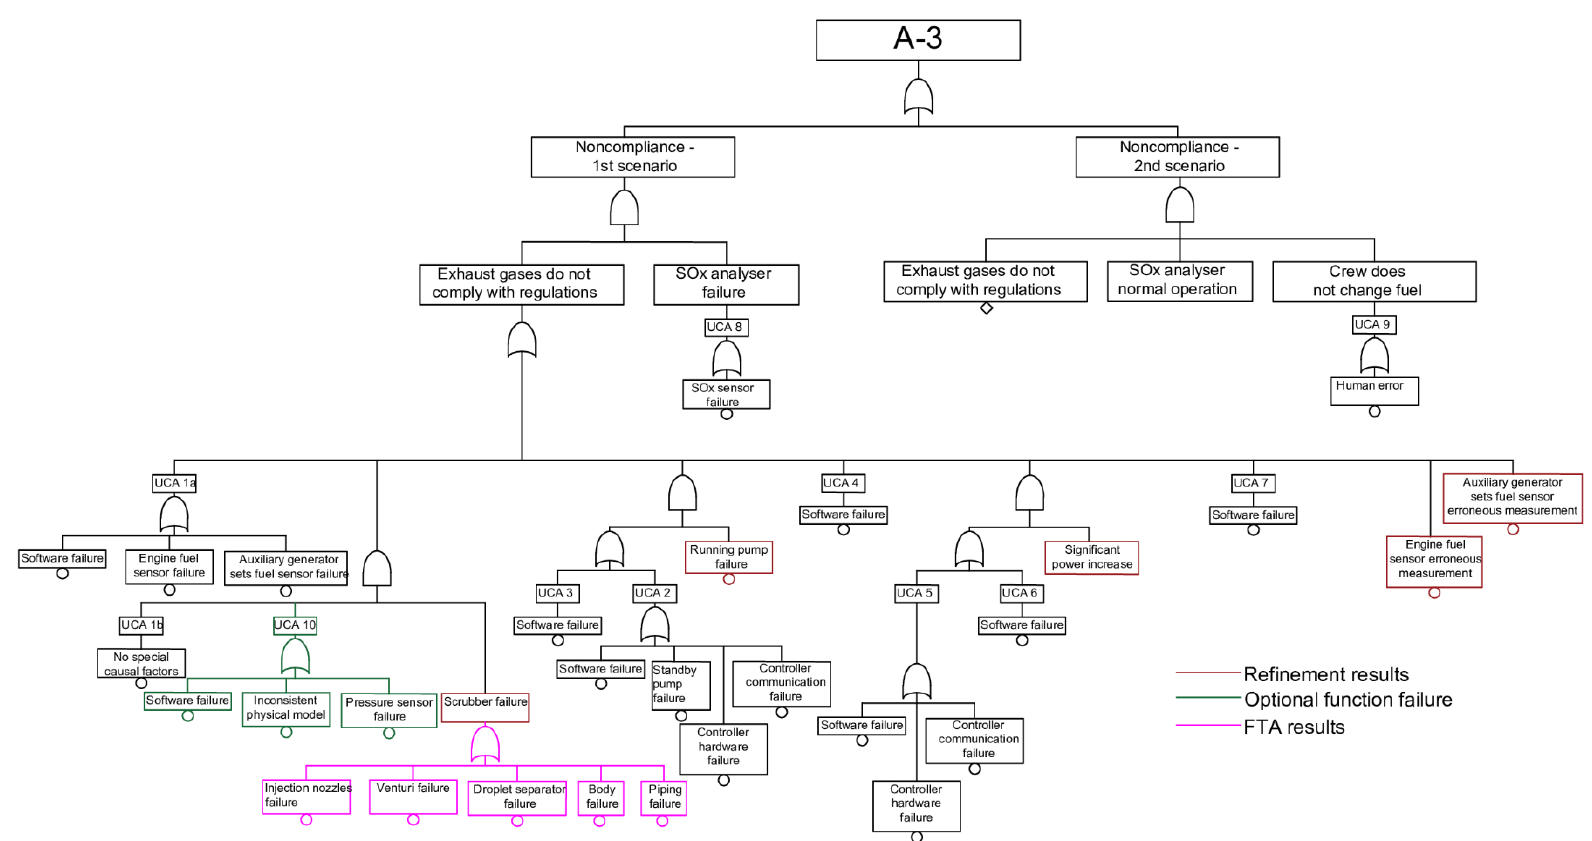
Figure 11. Refined Fault Tree developed in Step 9.